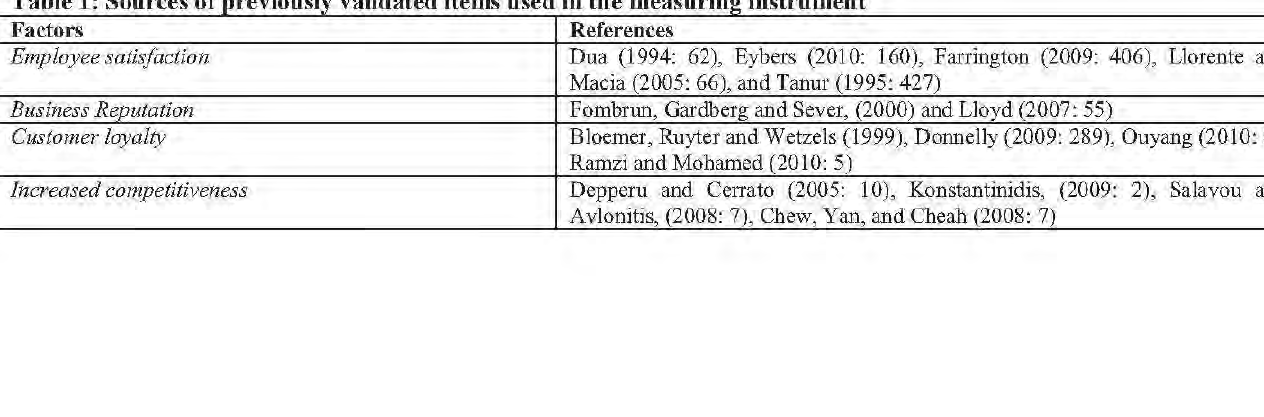
Table 1: Sources of previously validated items used in the measurin~ instrument